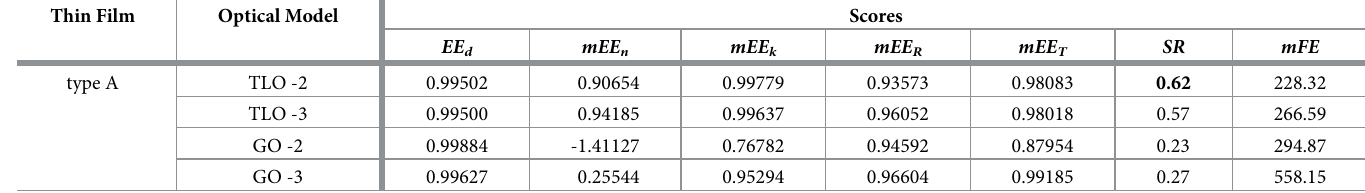
Table 3. Estimation performance of the adopted oscillator ensemble models applied on 100 samples of type A films, picked randomly from the fully-synthetic data set. EE : R 2 -score between original and estimated thickness values, mEE d between original and estimated k ( λ ) arrays; mEE R : mean of R 2 -scores between original and estimated R ( λ ) arrays; mEE T : mean of R 2 -scores between original and estimated T ( λ ) arrays; SR : success rate = number of successful occasions ( n ss )/ total occasions ( n s ); and mFE : average number of function evaluations: ð 1 = n denotes the average number of function evaluations (iterations × population